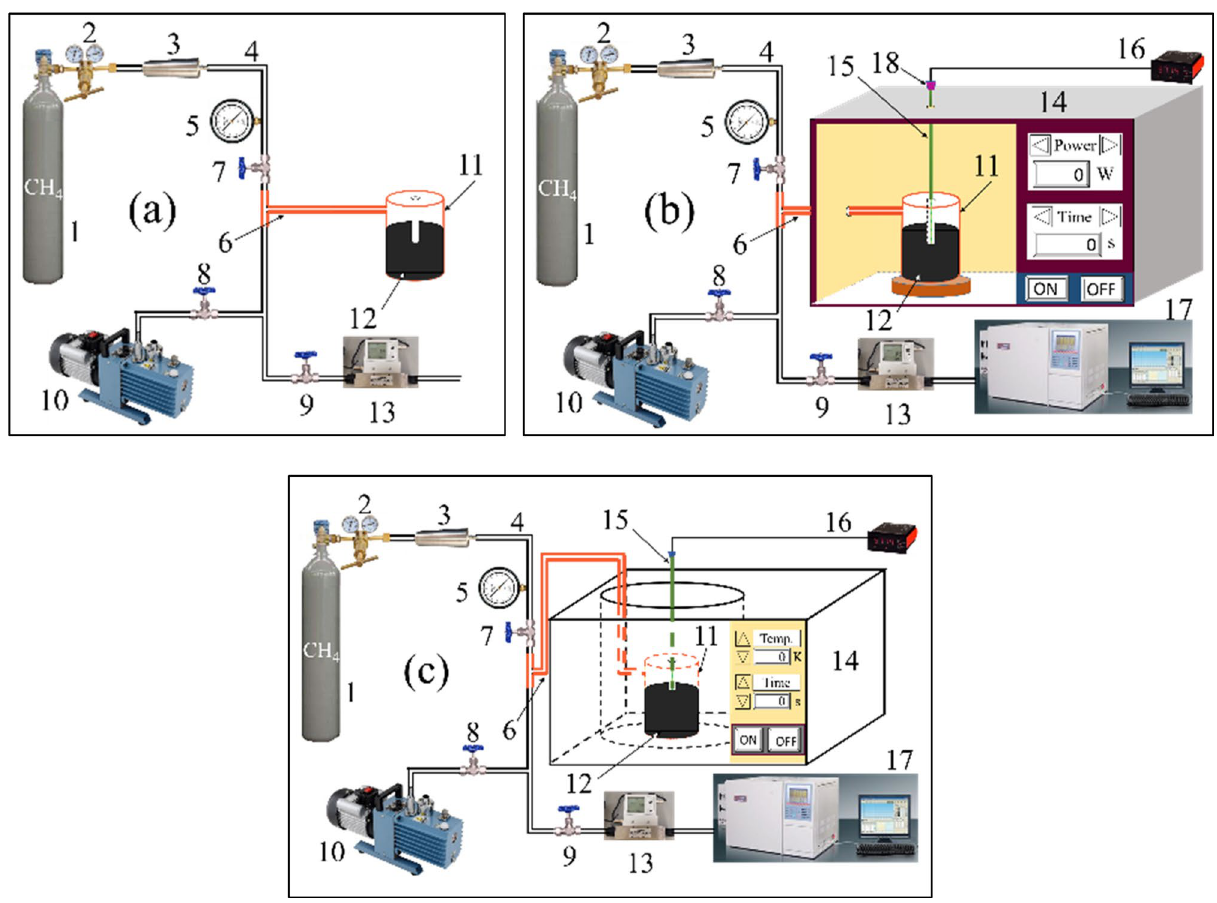
Figure 2. Experimental apparatus used for measuring methane desorption: ( a ) at room temperature desorption; ( b ) under MH; ( c ) under CH. 1—Gas container (99.99% CH 4 ), 2—Reducing valve, 3—Buffer tank, 4—Steel pipe, 5—Precision pressure gauge, 6—Teflon pipe, 7–9—Valves, 10—Vacuum pump, 11—Teflon canister, 12—Coal sample, 13—Flow meter, 14 on ( b )—Microwave generator, 14 on ( c )—Ultra-thermostat, 15— Thermocouple, 16—Temperature indicator, 17—Gas chromatograph, 18—Filter